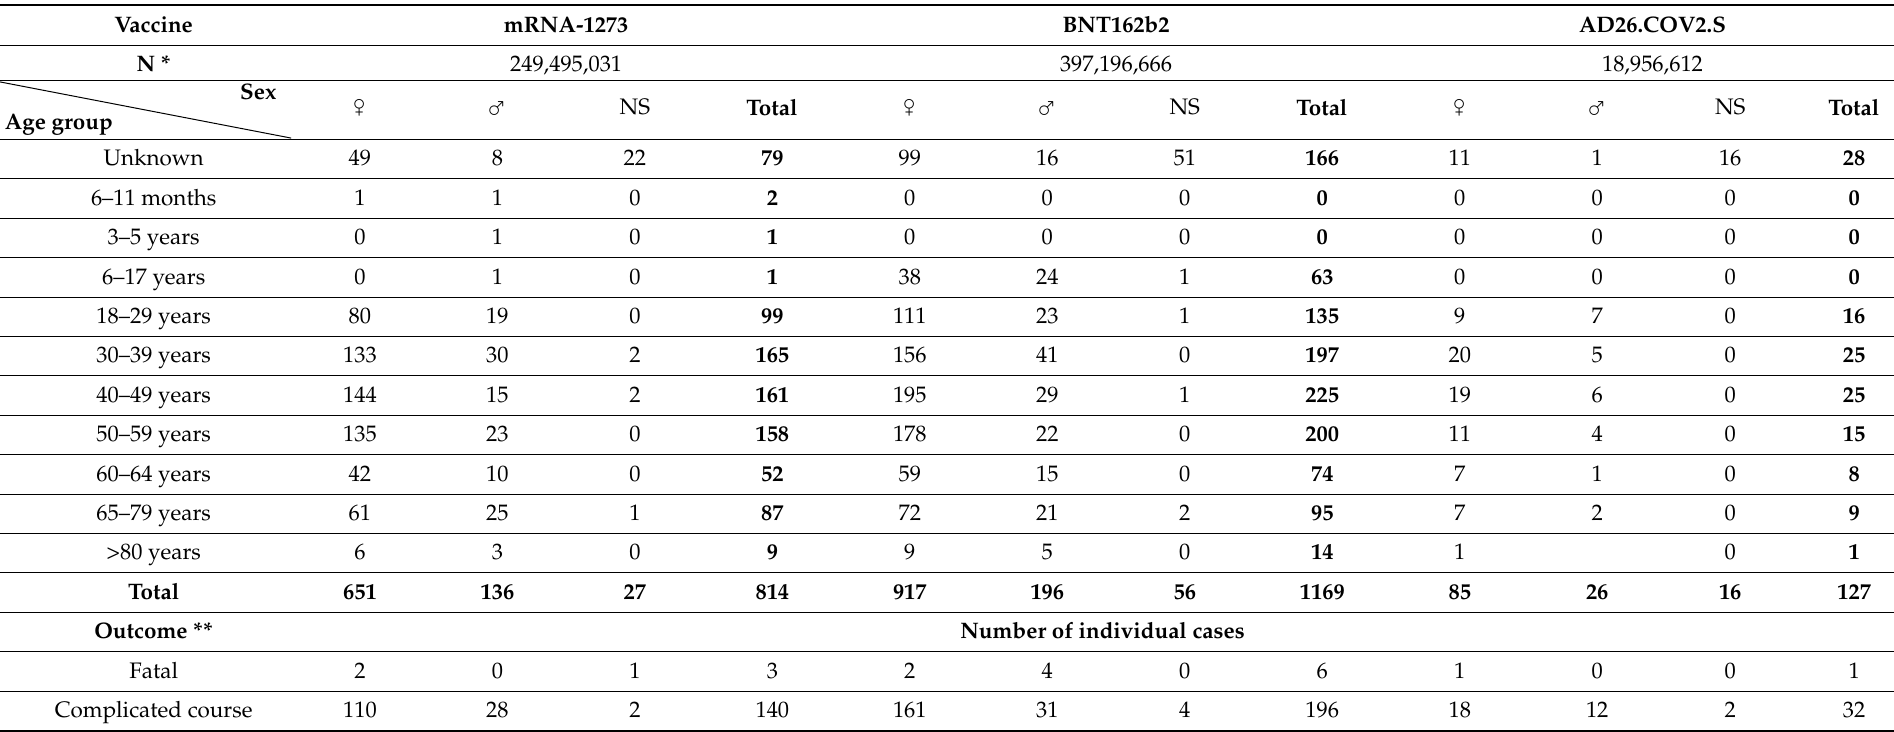
Table 3. Description of anaphylactic reaction cases post-COVID-19-vaccination reported by the VAERS from week 52, 2020 to week 1,